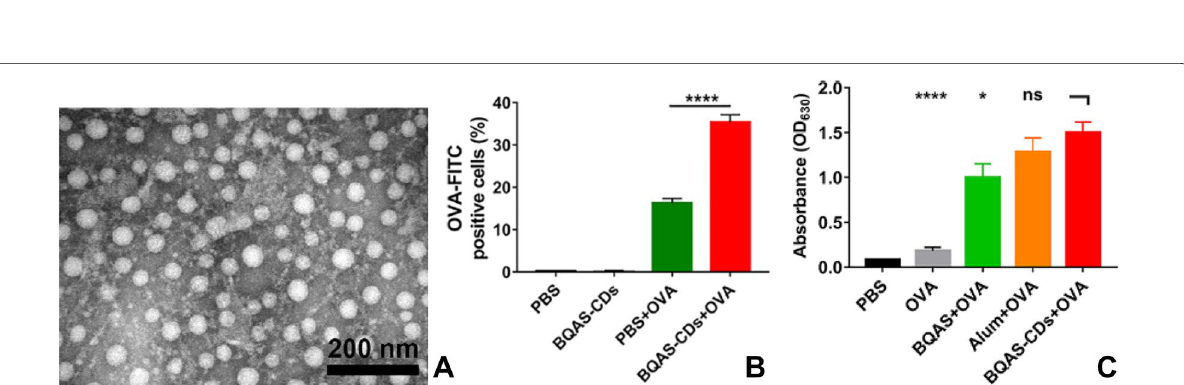
Fig. 10 A TEM image of OVA-CQDs complex. B Percentage of positive BMDC cells after incubating with OVA and OVA conjugated CDs. C ELISA result of IgG concentration in sera of BALB/c mice intramuscularly immunized with different adjuvants: BQAS, alum, or CQDs [204]. Reproduced